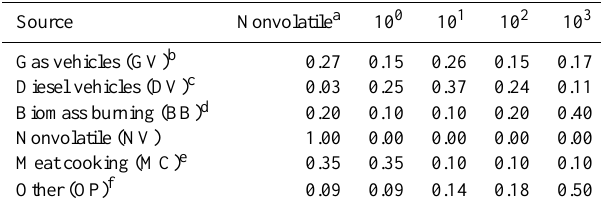
Table 1. CMAQ-VBS volatility distribution of POA emissions from gasoline vehicles, diesel vehicles, biomass burning, nonvolatile (e.g., fugitive dust), meat cooking, and “other”